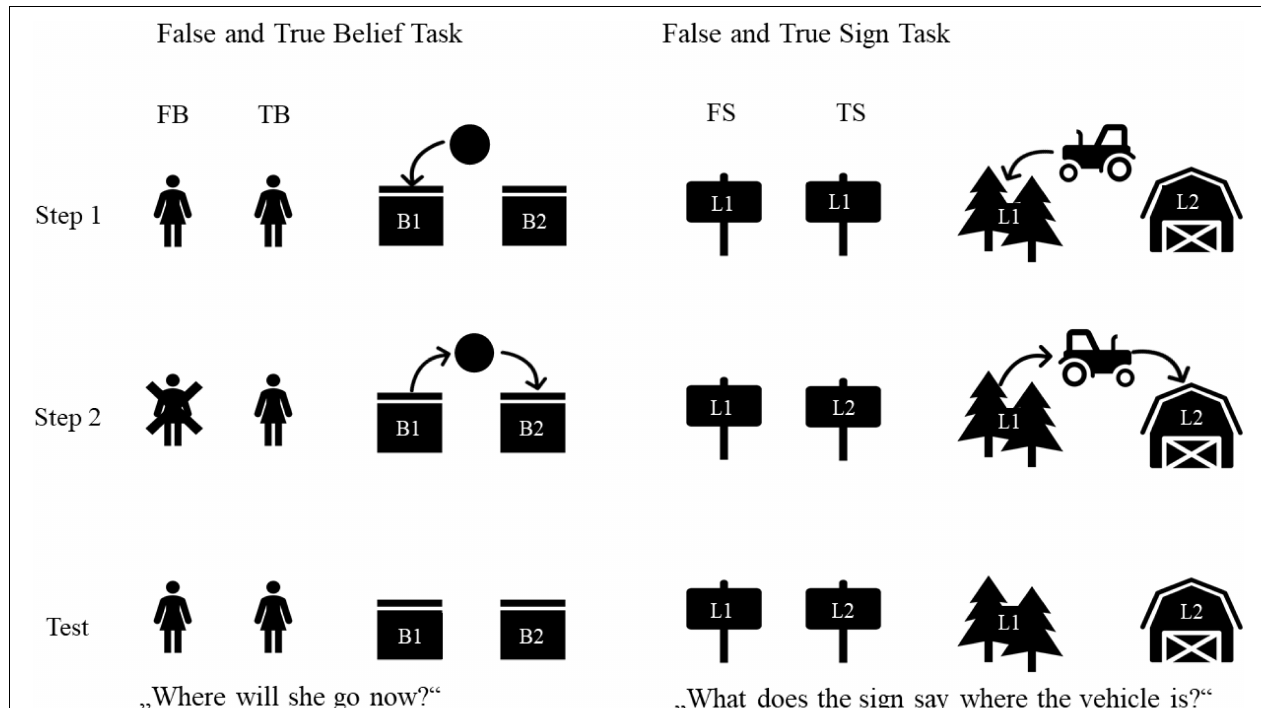
FIGURE 1 | Schematic procedure of False/True Belief and False/True Sign Tasks. Children were classified as passers on a given task if they got two out of two correct on belief tasks and one out of one correct on sign tasks (This makes it easier to pass the sign tasks than the belief tasks. We therefore conducted the same analysis as reported below with the first TB and first FB trial only. These analyses show the same results as reported below, see Supplementary Material .). They were classified as non-passers otherwise.